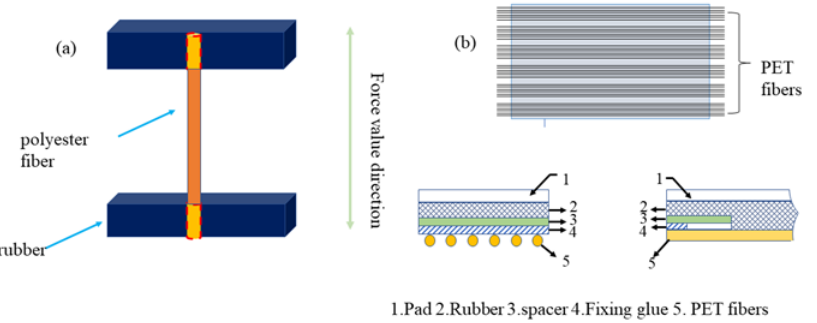
test Figure 3. Schematic diagram of test specimens ( a ) H pull-out sample ( b ) strip peeling adhesion test sample.